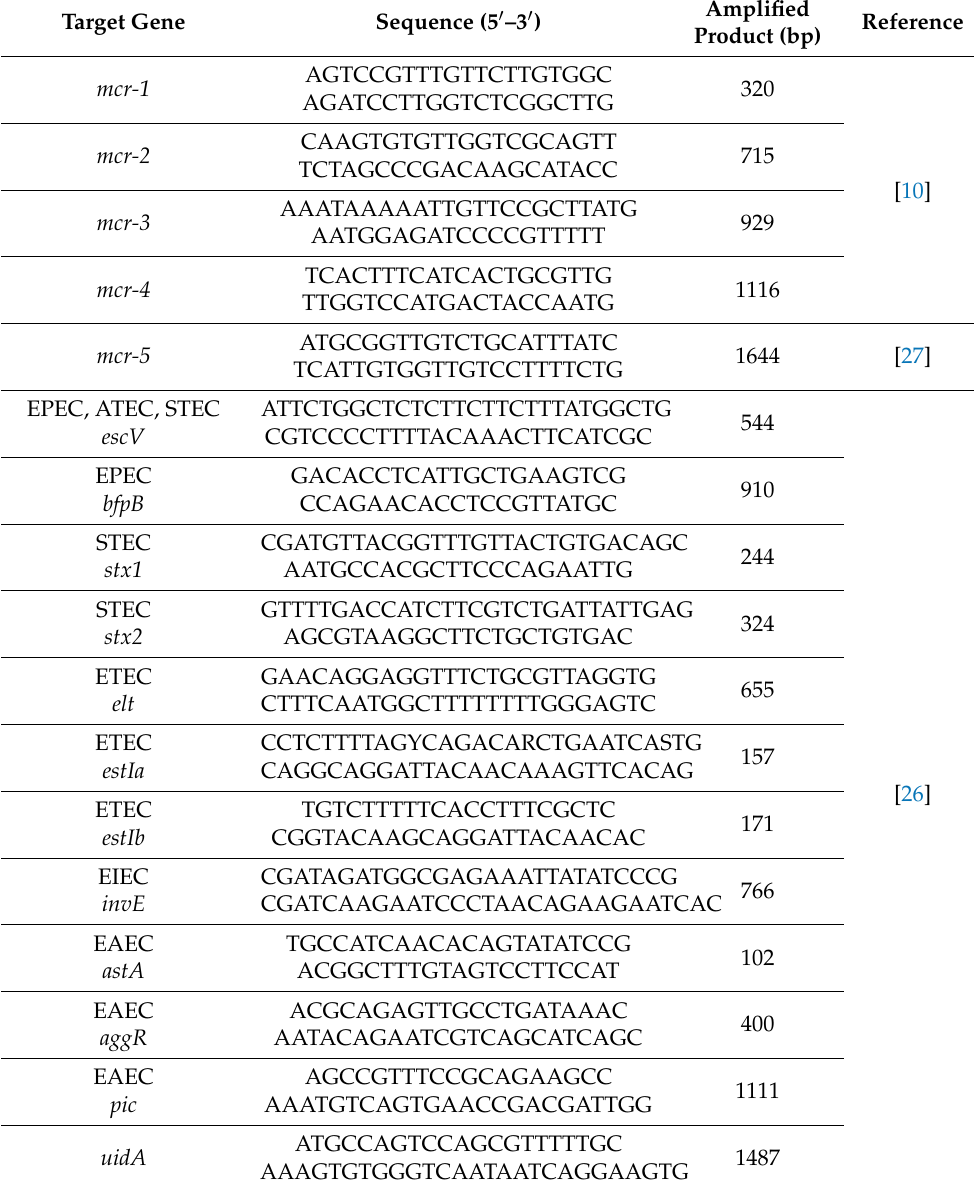
Table 1. Primers used for the multiplex PCR detection of mcr1 to mcr5 , E. coli virulence-related genes, and β -lactamase